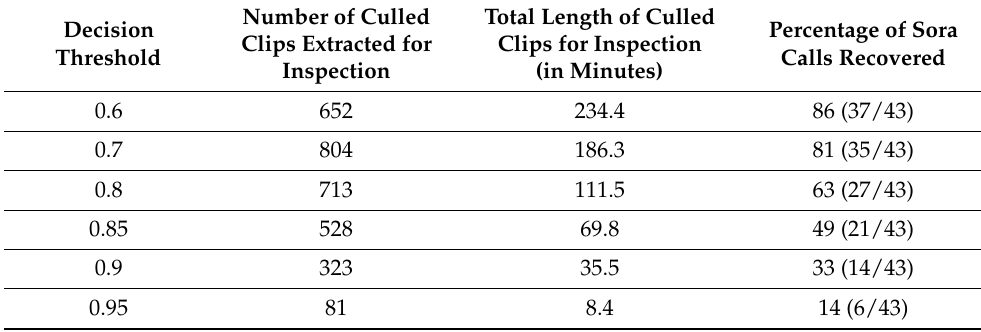
Table 6. Number of culled clips (of variable length), total length of clips, and percentage of Sora vocalizations recovered by culled clips on the final evaluation